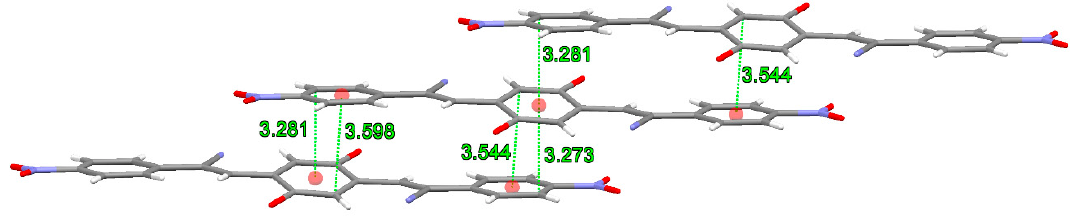
Figure 8. Facing of aromatic rings in C2 packing. Shortest distances involving centroids of aromatic rings are drawn as green lines. Aliphatic groups bonded at O3 and O4 and H atoms are not reported for clarity.